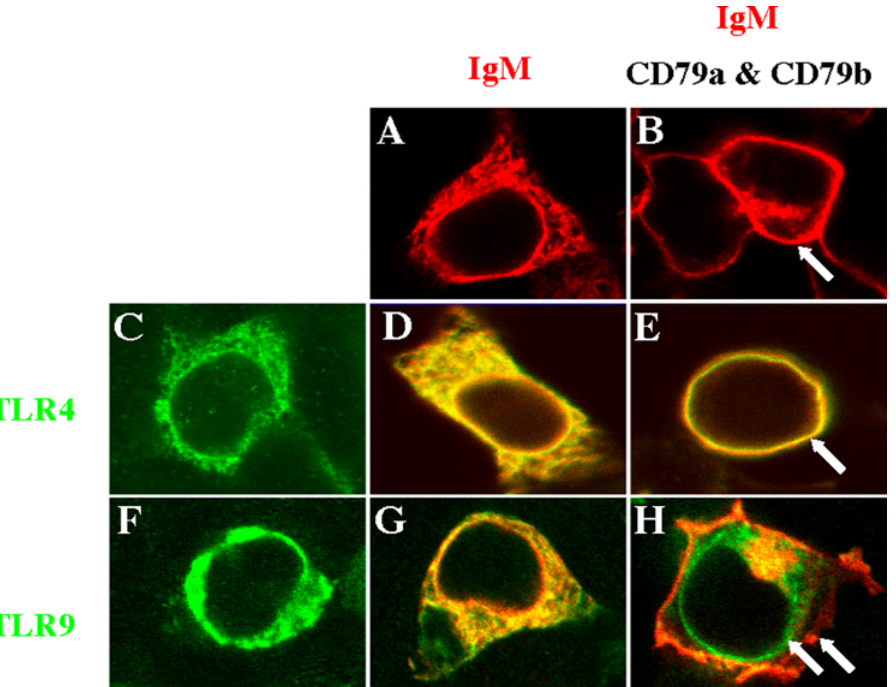
Figure 5. TLR4 and BCR are physically associated. HEK293 cells were transfected with BCR and HA-tagged TLR constructs, fixed, mounted, and examined by confocal microscopy. TLR staining (anti-HA followed by Cy3-conjugated anti- mouse IgG) was pseudo-colored green and IgM staining (with Cy5-conjugated anti-human IgM) was pseudo-colored red. Panels showing TLR/BCR co-transfection experiments (D–E and G–H) represent an overlay of the green and red channels. A and B. IgM HC and LC constructs (BCR, shown in A) are fully cytoplasmic (A) but they are shifted to the membrane upon transfection with CD79a and CD79b coding constructs (B, arrow). C–H. HA-tagged TLR4 (C–E) or TLR9 (F–H) were transfected alone (C and F) or co-transfected with the IgM HC and LC constructs (D and G) or HC/LC + CD79a/CD79b (E and H). HA-tagged TLR4 (C–E), but not HA-tagged TLR9 (F–H), is dragged to the membrane upon cotransfection with CD79a and CD79b coding constructs.